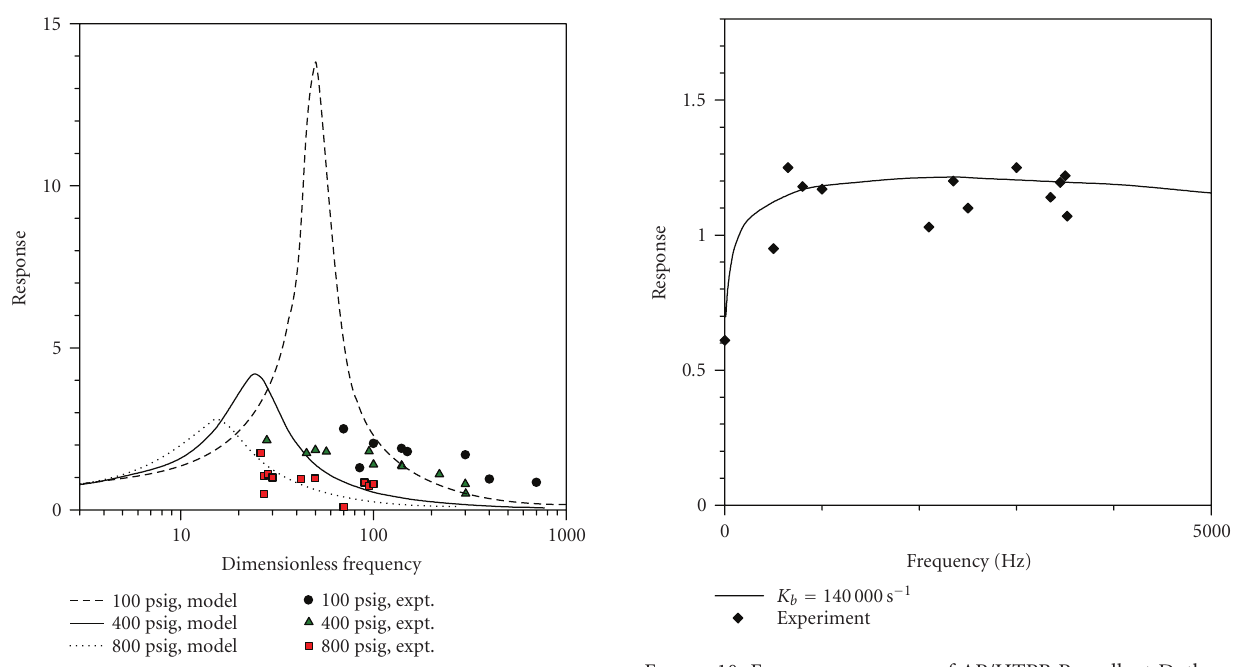
Figure 9: Frequency response of AP/PBAN Propellant C, theory ( K b = 18000 s − 1 , Δ H s = 68 000J/kg) and experiment [22], in terms of real part of pressure-based function, at di ff ering pressures.